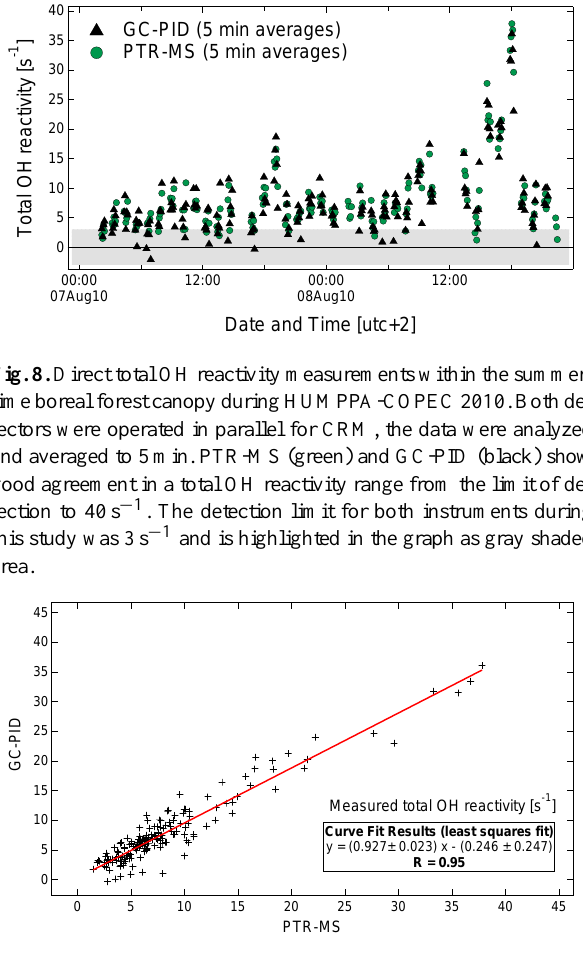
Fig. 9. Correlation of PTR-MS and GC-PID results for summertime boreal forest total OH reactivity during HUMPPA-COPEC 2010. A linear least squares curve fit is given, its slope and the Pearson R of the correlation between the two instruments.